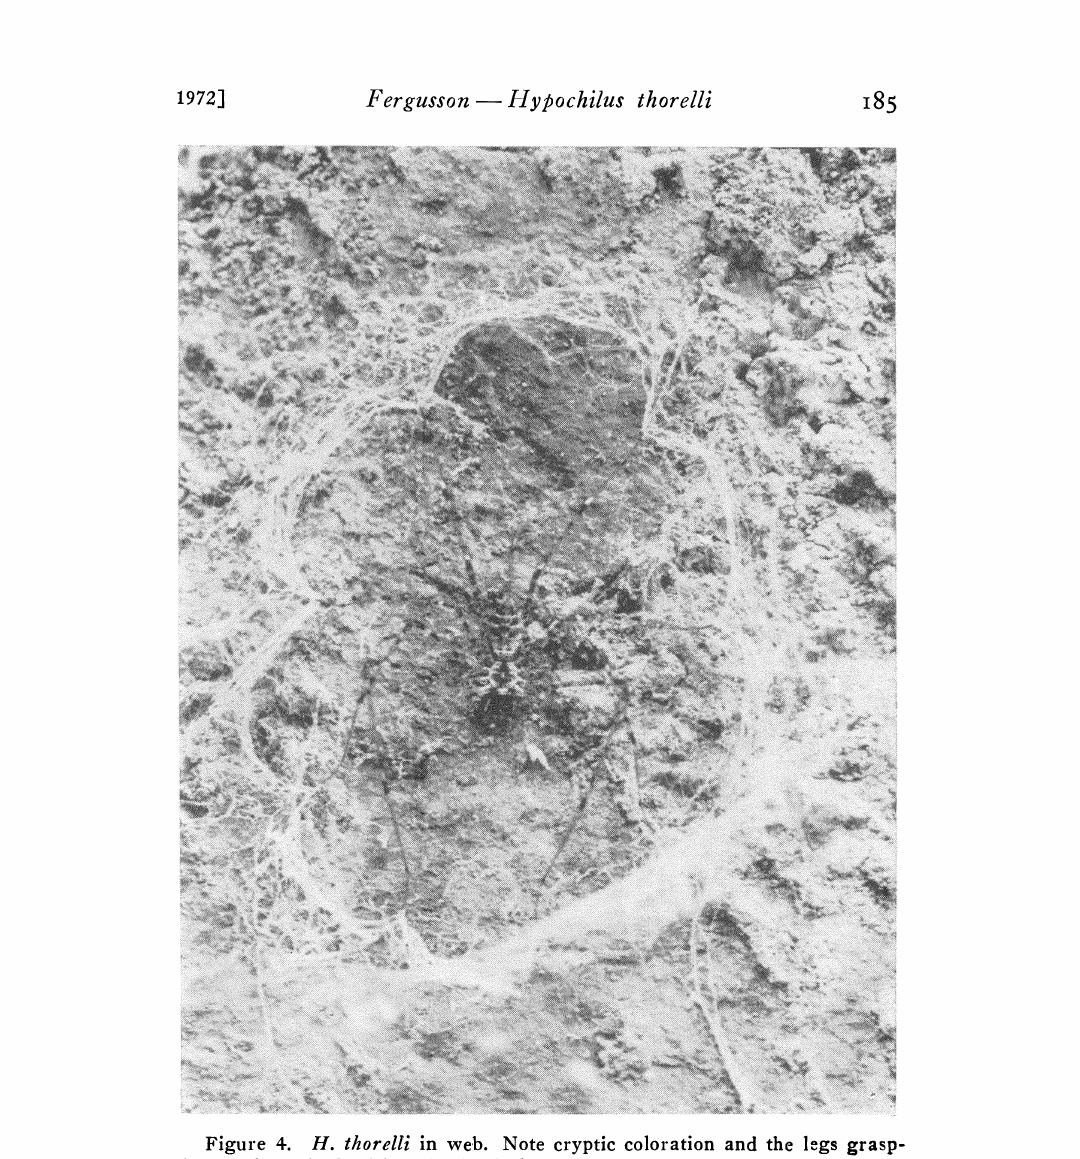
Figure 4. H. thorelli in web. Note cryptic coloration and the legs grasp- ing the lampshade. Photo by L.